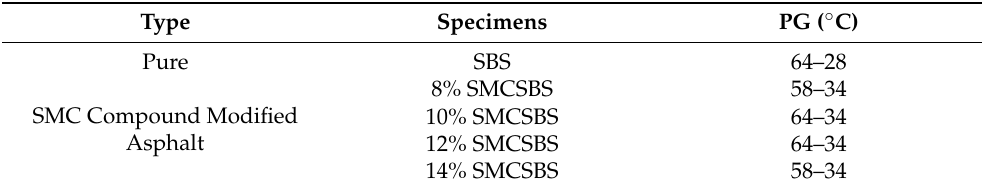
Table 7. Performance grade (PG) results of SBS and the SMCSBS.